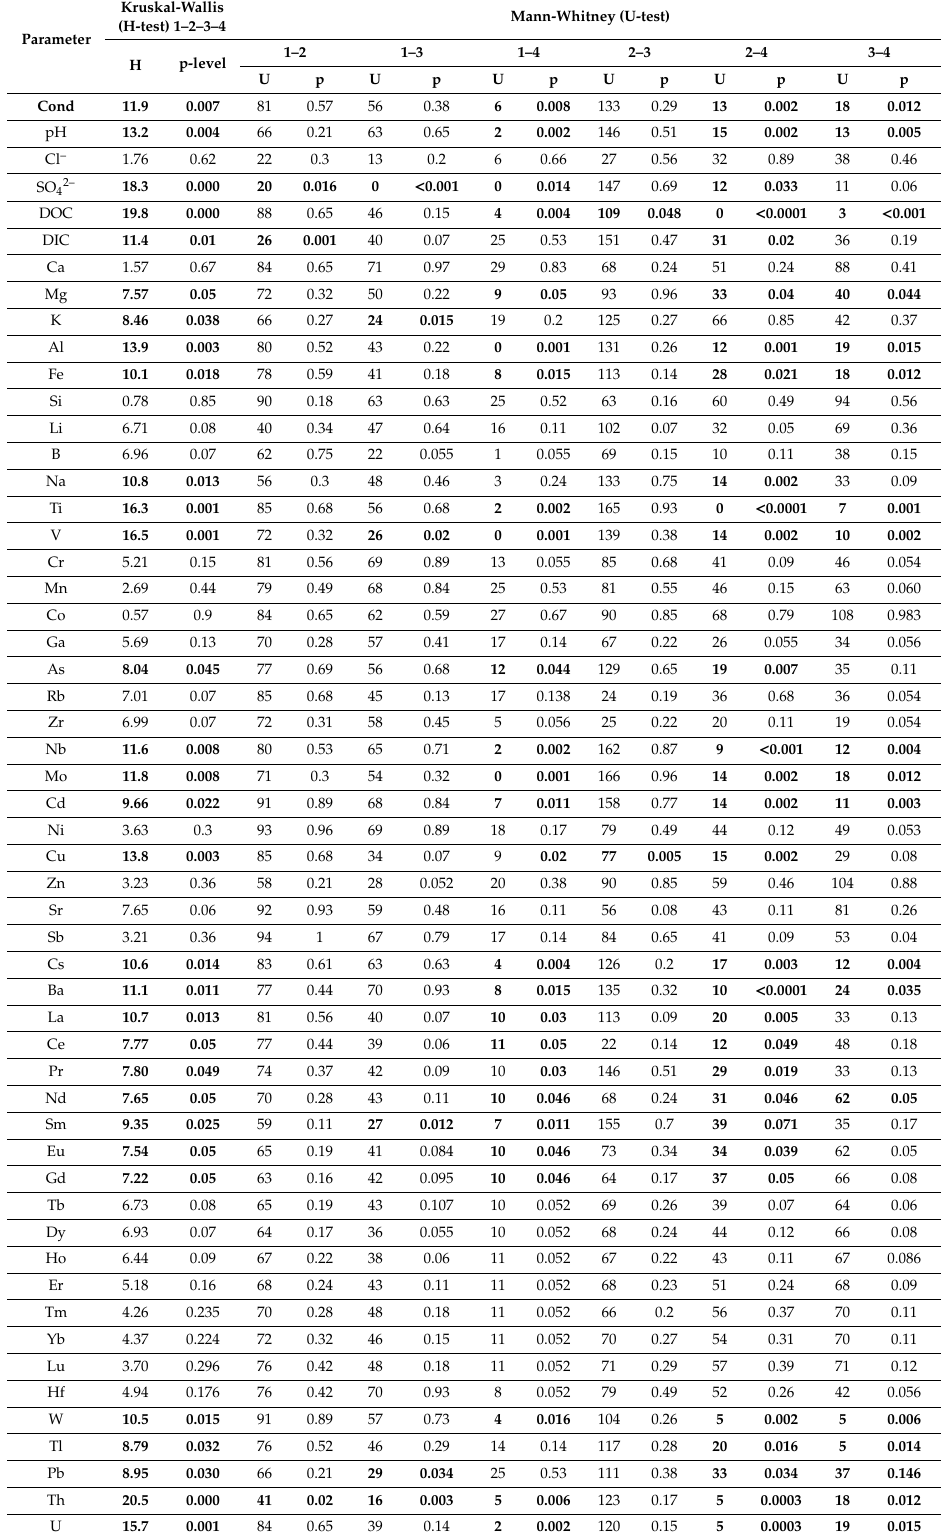
Table A2. Statistical di ff erence ( p < 0.05) in hydrochemical parameters between bog waters with di ff erent hydrological regimes of the KS Tazovsky: 1–polygons occupying elevated dry positions; 2–degraded and flooded polygons and small cracks between polygons; 3–large cracks and fens without watercourse; 4–lower parts of the fens with